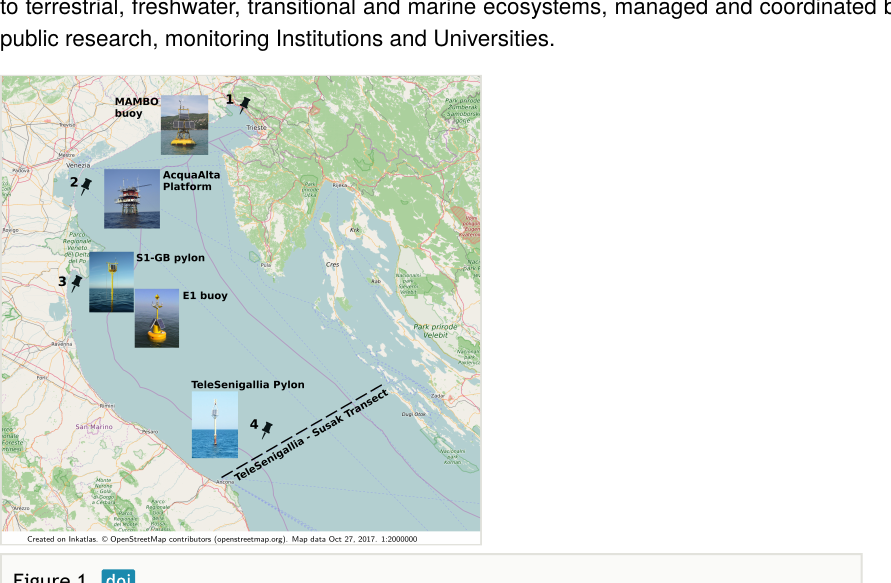
2: Gulf of Venice and Acqua Alta Tower, 3: Po Delta and Romagna Coast and S1-GB and E1 buoys, 4: Senigallia-Susak Transect and TeleSenigallia Pylon (Minelli et al.